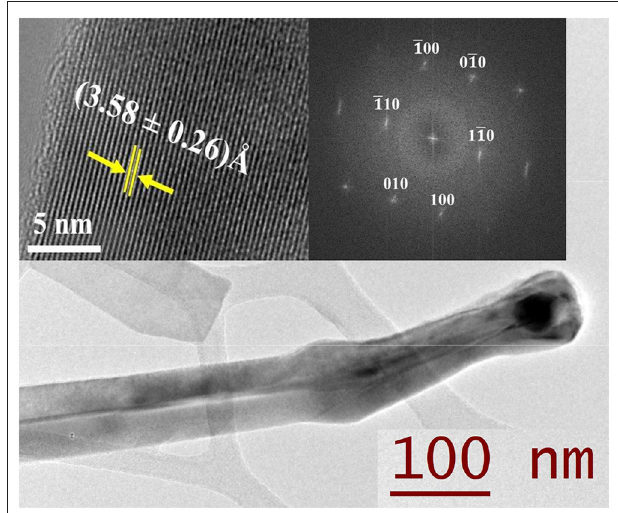
FIGURE 4 | TEM image of the nanowires at low resolution. The left inset shows a high-resolution TEM image in which it is possible to observe the crystalline planes. The Fast Fourier Transform is shown in the right inset, which can be indexed as the [001] zone axis.